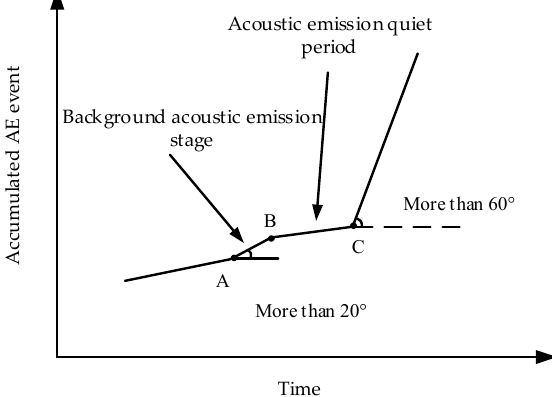
Figure 11. Definition of AE quiet period.